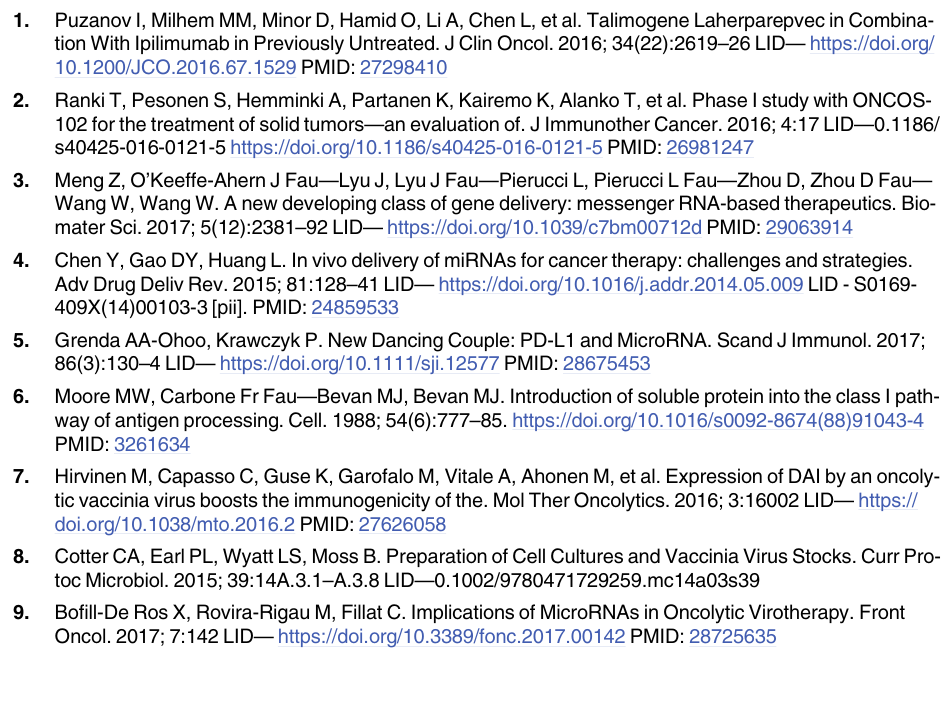
S1 Table. miRNAs selected from literature for their ability to down-regulate PD-L1 in dif- ferent types of human